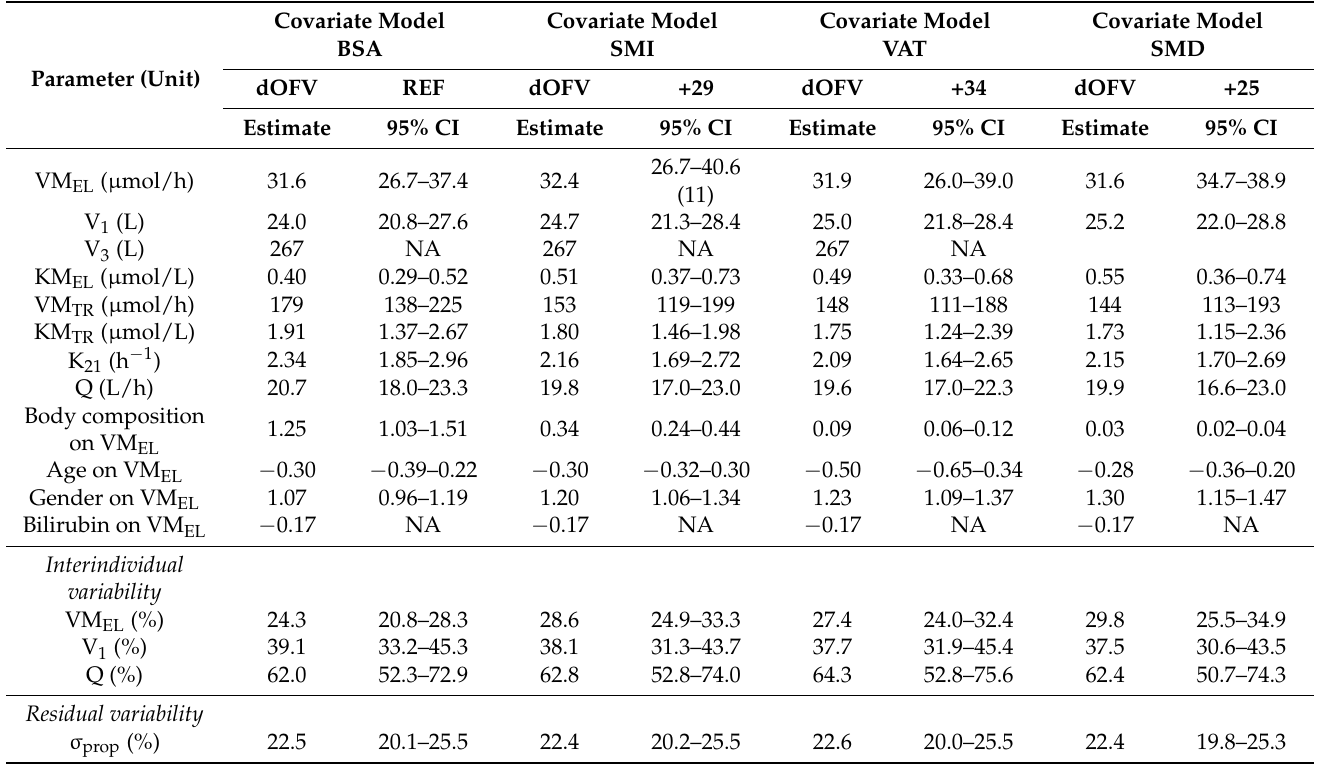
Table 2. Population pharmacokinetic parameters of paclitaxel of the covariate model of BSA, SMI, VAT, and